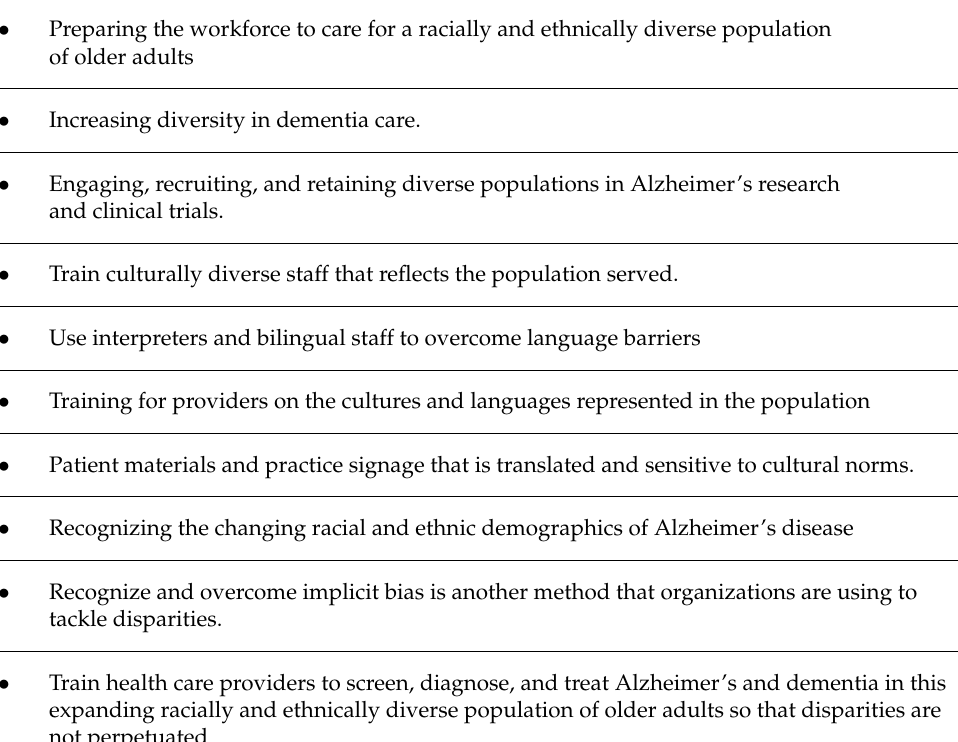
Table 5. Alzheimer’s Association Guidelines to address health disparities for Alzheimer’s care- givers